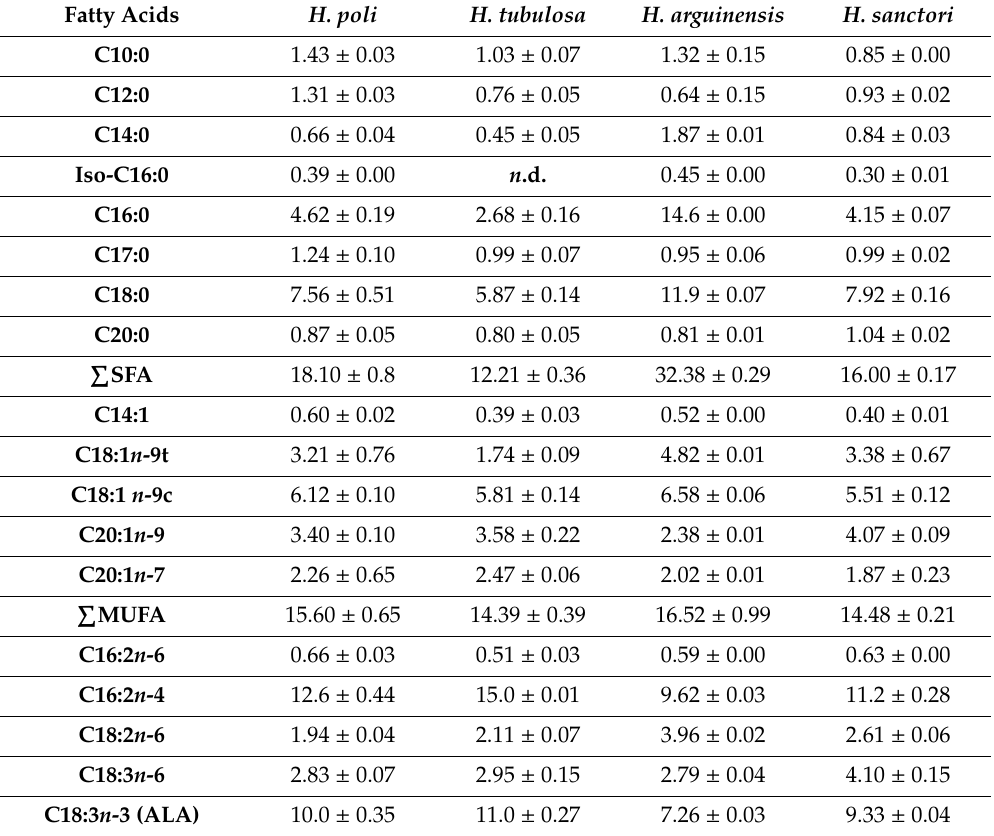
Table 3. Fatty acid compositions of the studied holothurians (%) analysed by CPG. Mean ± SD [ n = 3]; n .d. not